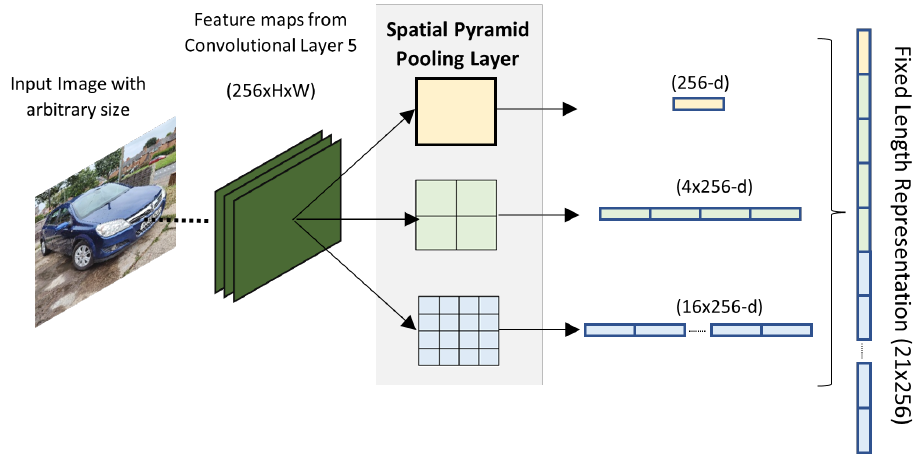
Figure 8. Spatial Pyramid Layers and the output vectors